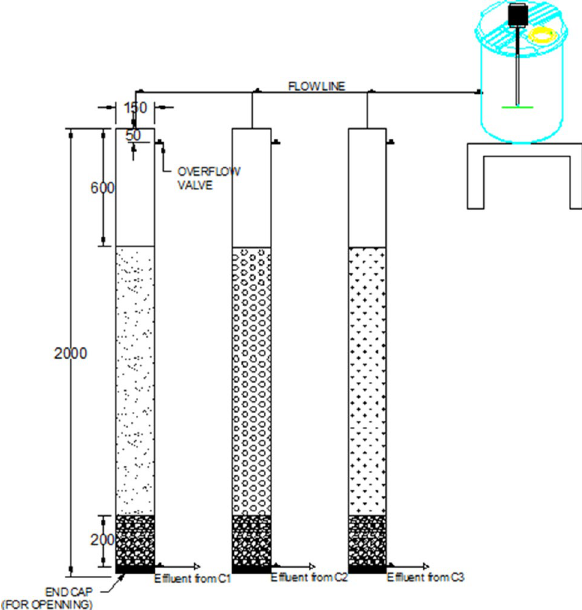
Fig. 8 The experimental setup for run (1) for optimum composite